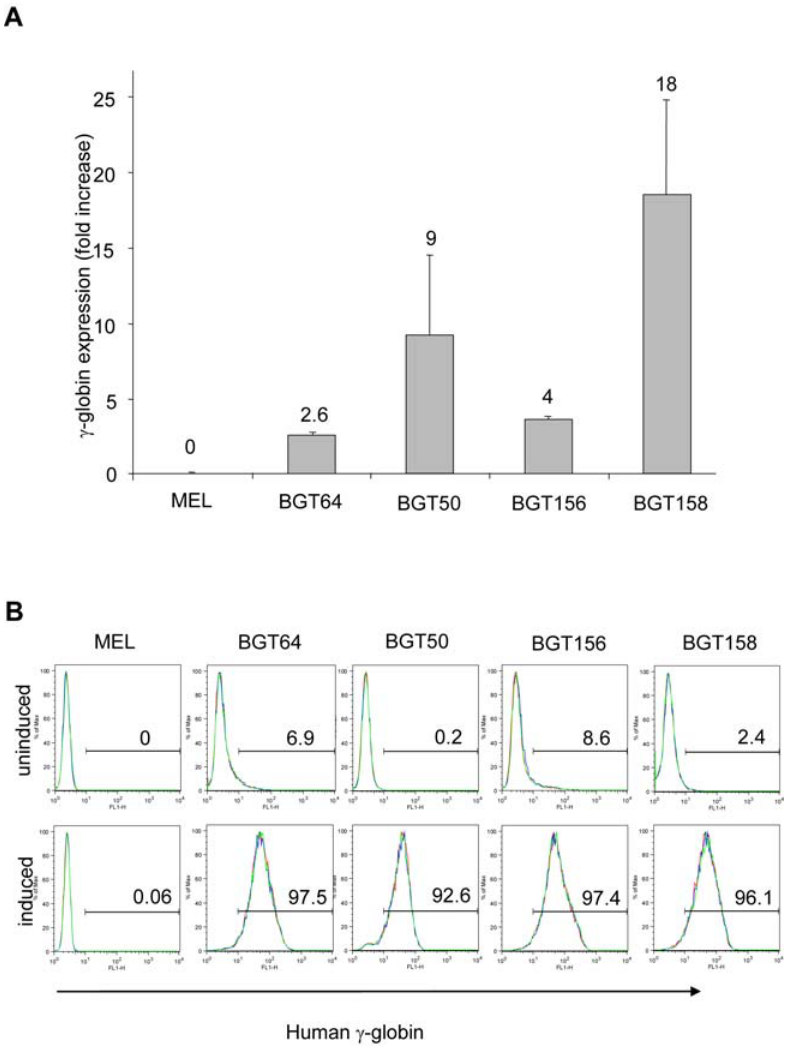
Figure 5. The BGT158 transgene responds with the highest fold induction in MEL cells. (A) qRT-PCR analysis of A c -globin RNA expression by MEL BGT64, MEL BGT156 and MEL BGT158 cell lines. Mean fold increase of RNA levels 6 SE is shown on the third day after induction with 5 mM HMBA calculated from triplicate qRT-PCR samples from 2 independent clones for each transgene. MEL and MEL BGT50 cell lines are negative and positive controls respectively. (B) Flow cytometry with and without 6 days of HMBA induction shows the cell % expressing A c -globin protein, and demonstrates that all constructs produce roughly equivalent protein levels.